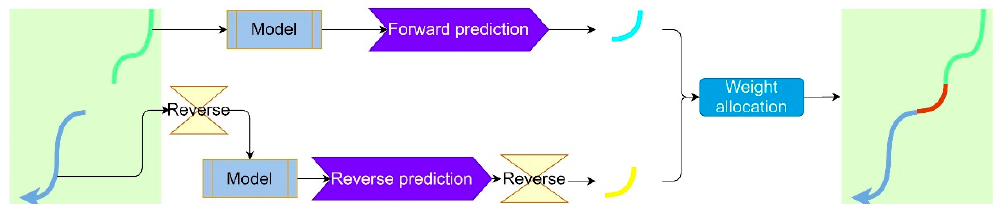
Figure 6. Track fusion of the proposed model. The forward prediction is obtained by using the pre-break trajectory, the reverse prediction is obtained by using the post-break trajectory, and the final predicted trajectory is obtained by inverting the reverse prediction and weighting the two results by the entropy method.